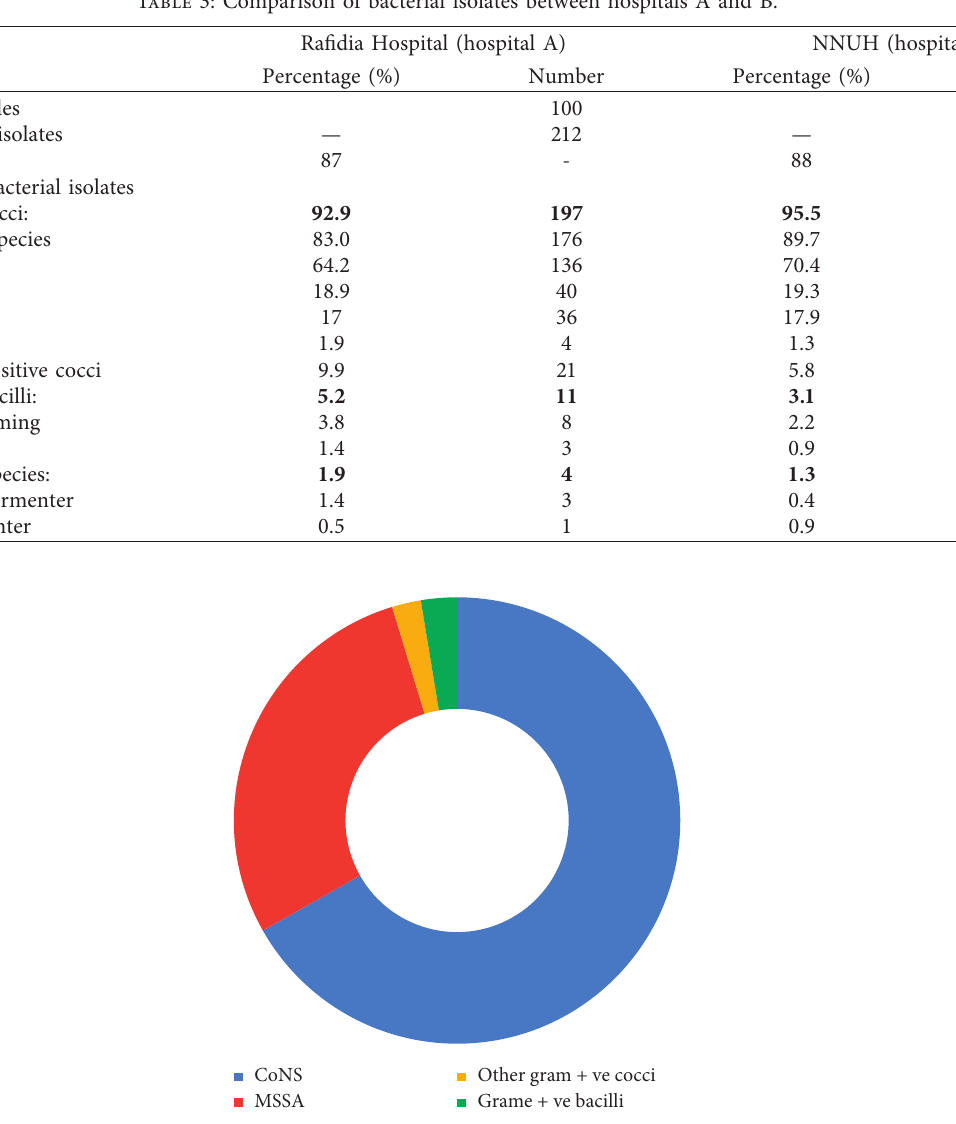
Figure 2: Distribution of bacterial isolates from non-HCW mobile phones. Table 4: Antibiotic susceptibility pattern of Staphylococci isolated from HCW and non-HCW